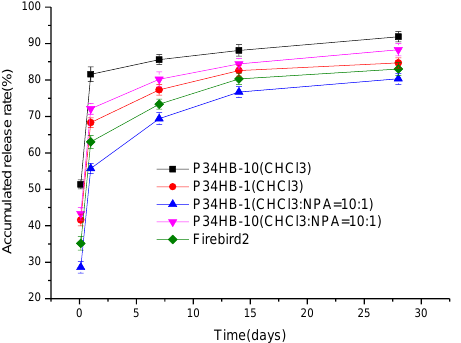
Figure 5. Drug release profiles for P34HB coating stents and Firebird2 ® stents.